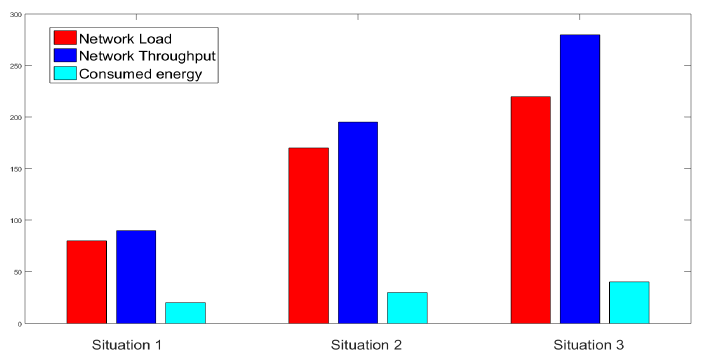
Figure 8. NS2 Simulation in Stage 1.